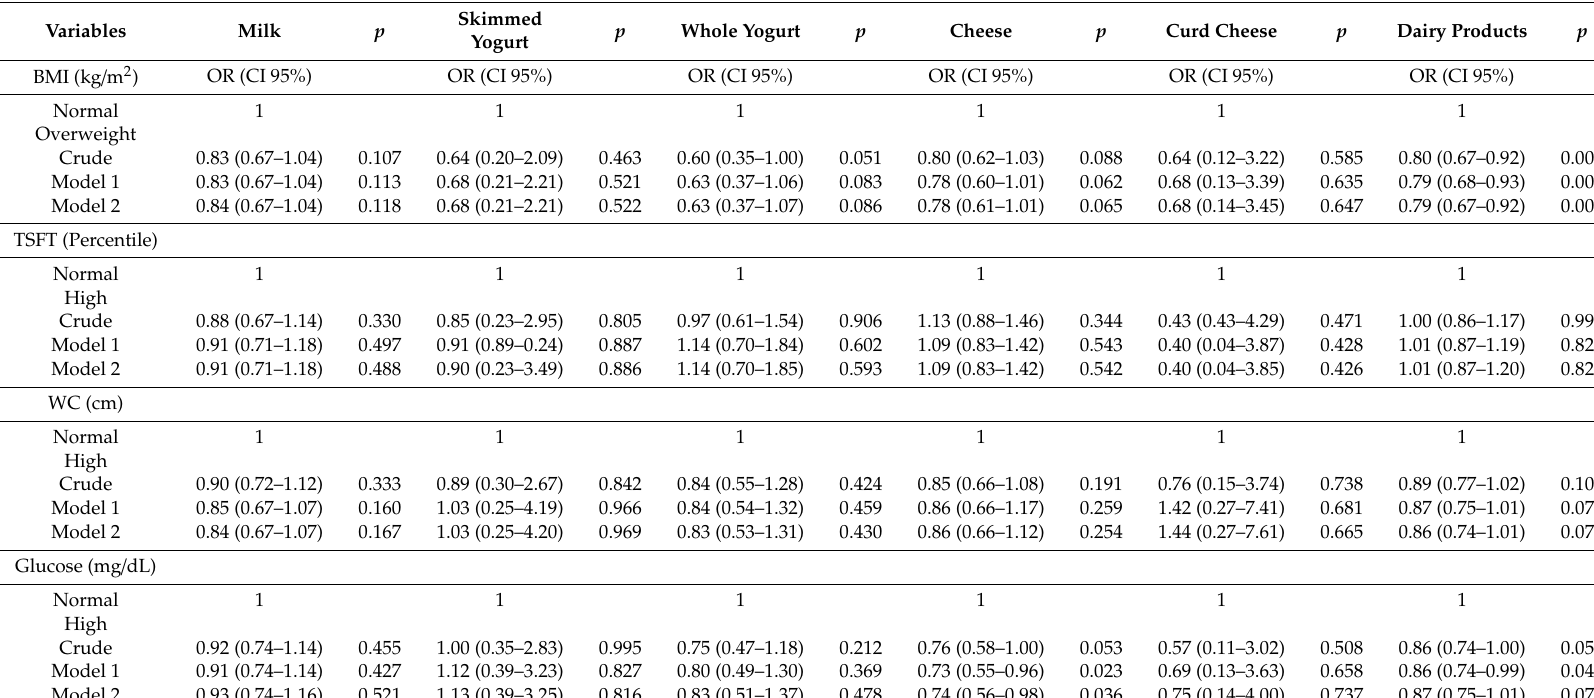
Table 4. Association (Odds ratio) between dairy intake with anthropometric measurements and blood glucose concentrations.